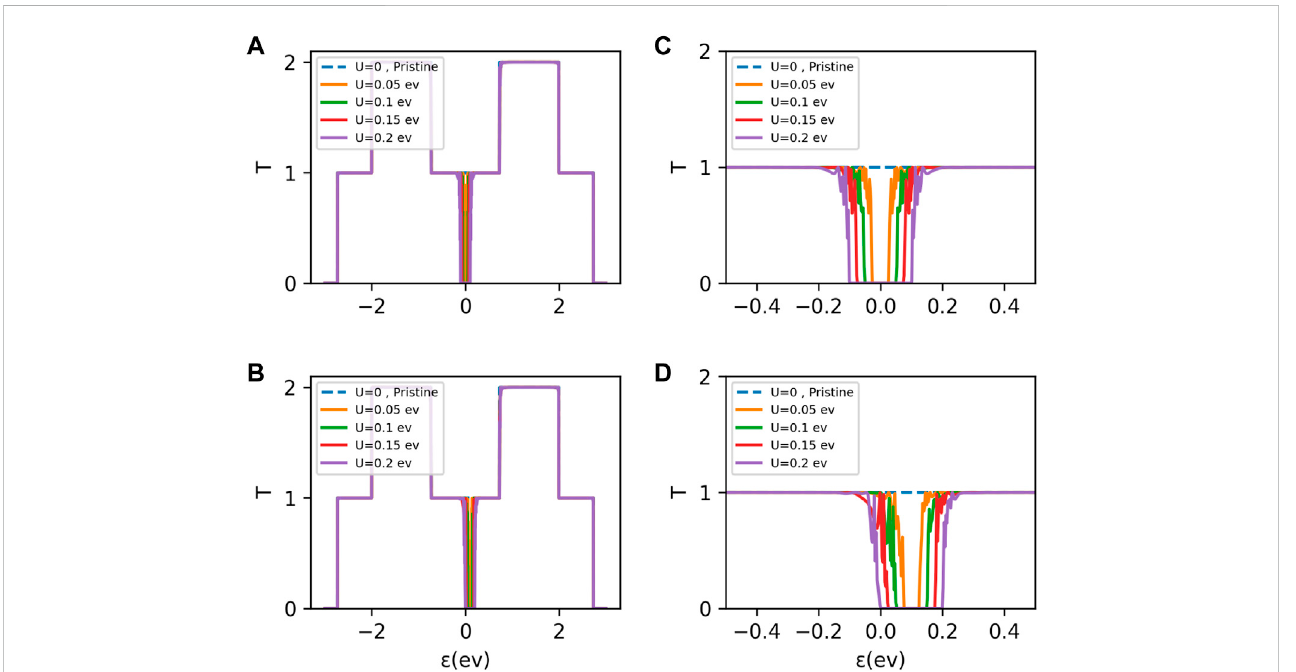
FIGURE 2 Transmission vs. Fermi energy for an A-SNR of width N = 5 and length L =80 for several external potential intensities, considering two different on-site energiesforthead-atoms. In (A) ε